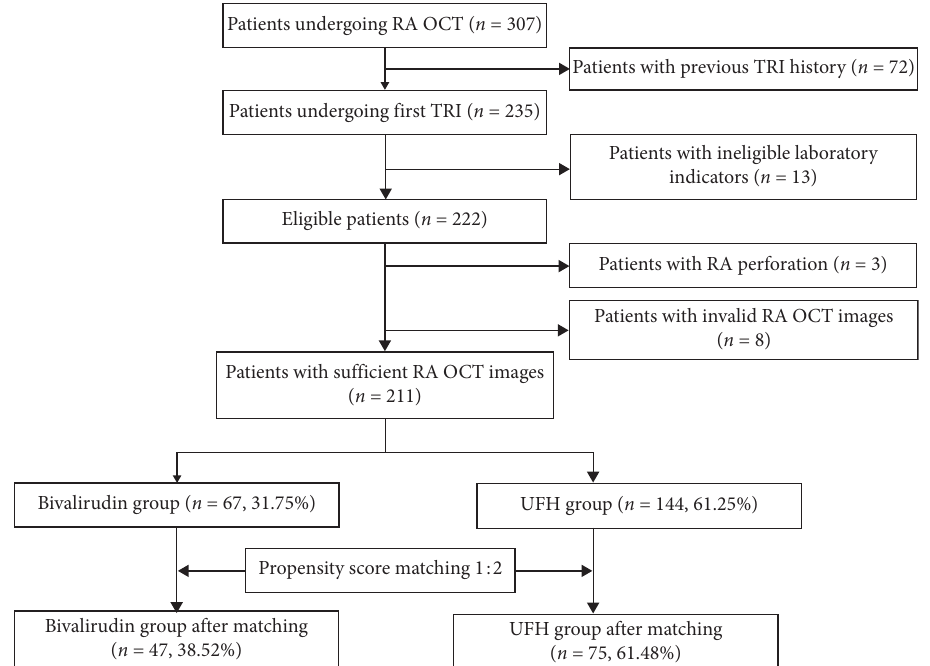
Figure 1: Patient chart of enrollment and propensity score matching. RA: radial artery, OCT: optical coherence tomography, TRI: transradial coronary intervention, and UFH: unfractionated